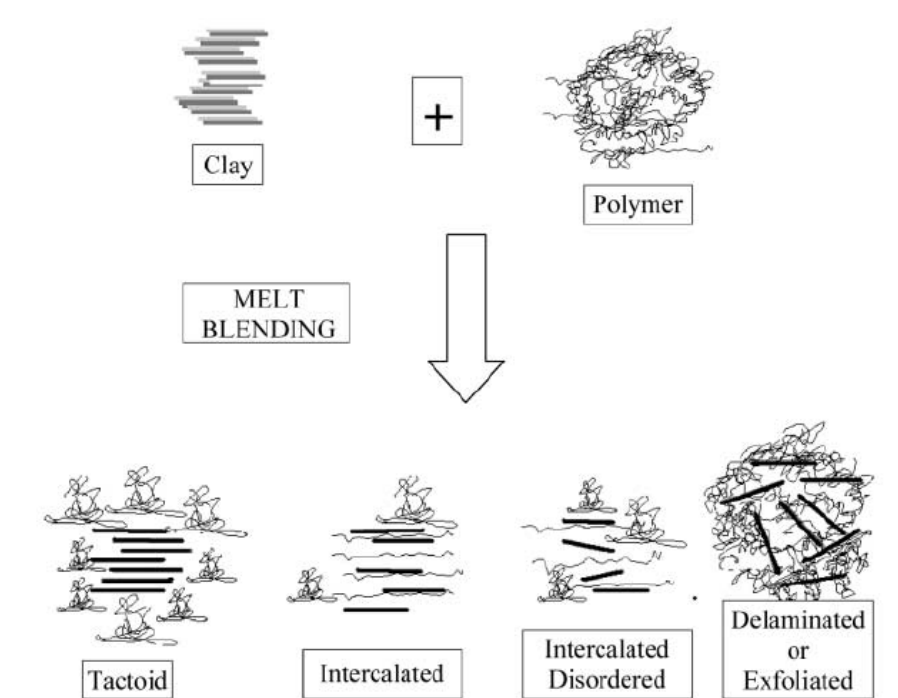
Figure 4. Schematic illustration of terminology used to describe nanocomposites formed from organoclays. Reproduced with permission from [106].